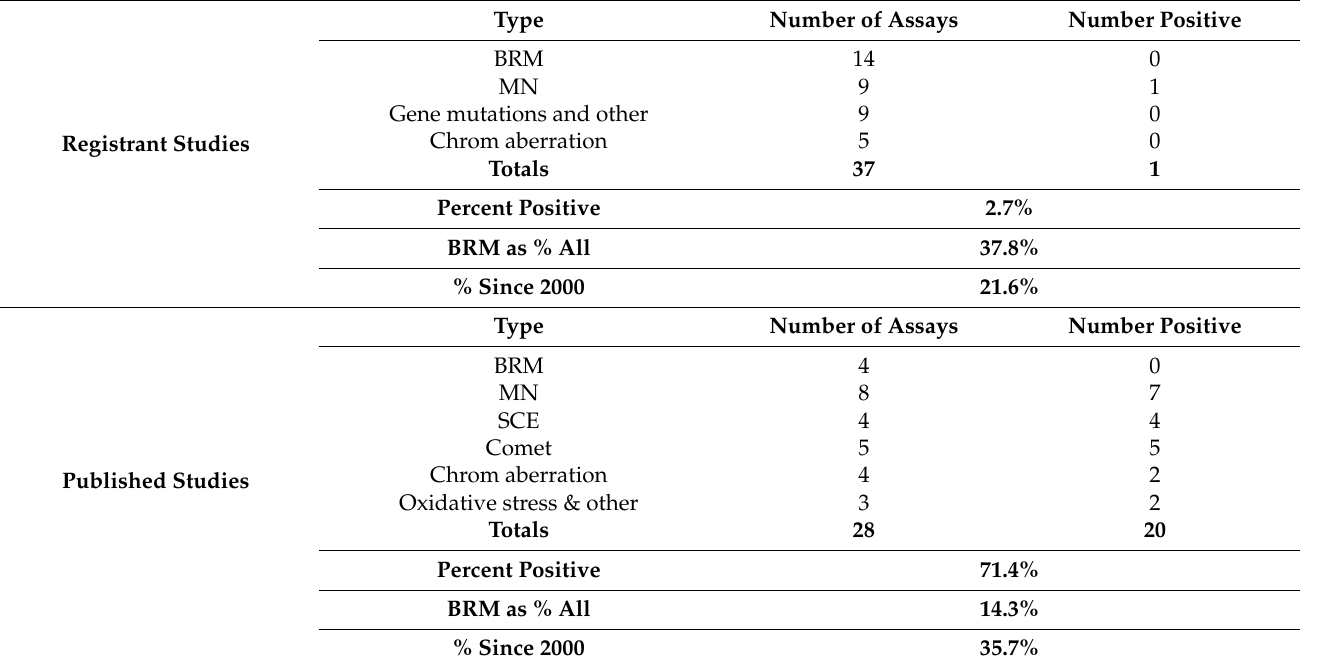
Table 7. OPP/EPA Evaluation of Glyphosate Genotoxicity Assays Referenced in the Glyphosate Oncogenicity Issue Paper (see